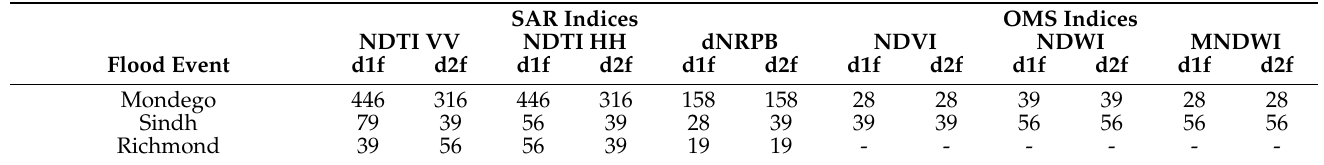
Figure 8. Comparison of SAR-derived index differences (NDTI—Normalized Differenced Temporal Index for both ( a ) vertical-vertical (VV) and ( b ) vertical-horizontal (VH) polarizations; ( c ) dNRPB— difference of Normalized Ratio Procedure between Bands) alongside the delineation of the Reference Observed Event (ROE) [51] for the North Complex fires (USA) (coordinate reference system: NAD83 / California zone 2). Table 3. Optimal bin number values of both SAR and OMS indices for d1f and d2f in respect to the flood event case